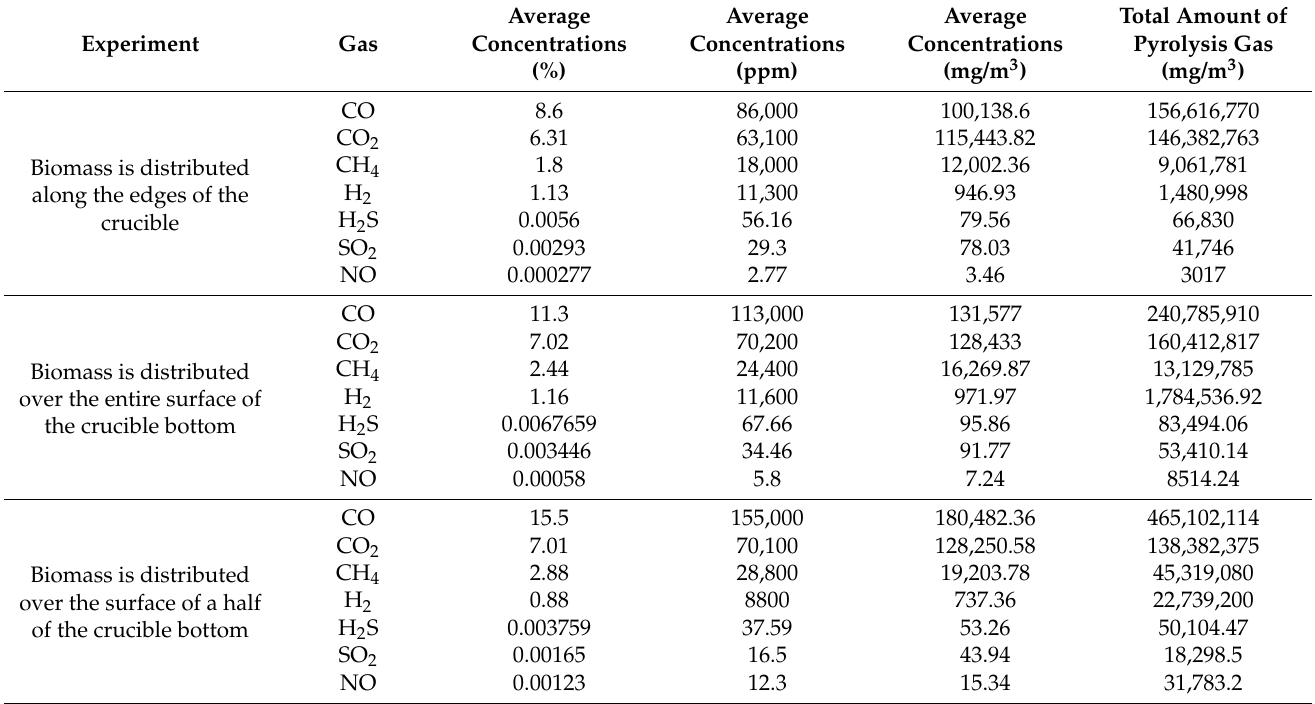
Table 4. The yield of the main